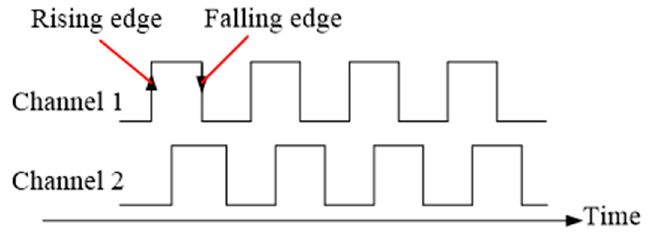
Figure 2. The typical pulse signals output by the optical receiver.